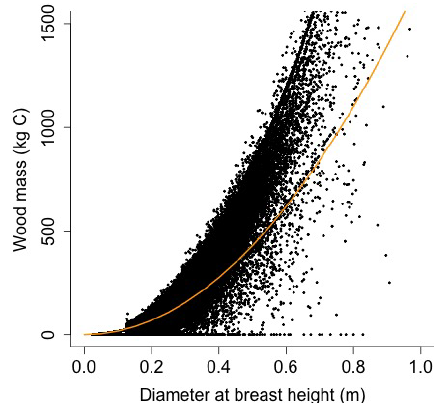
Figure D14. Wood mass model fit to FIA data for Acer (displayed at mean height of Acer ).